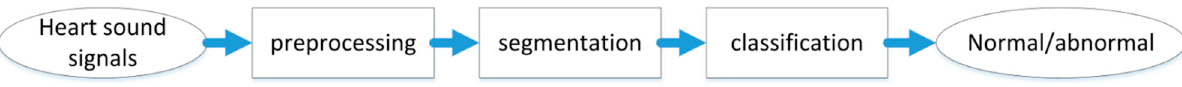
Figure 8. Diagram of the propose method: pre-processing phase, segmentation phase and classification phase.